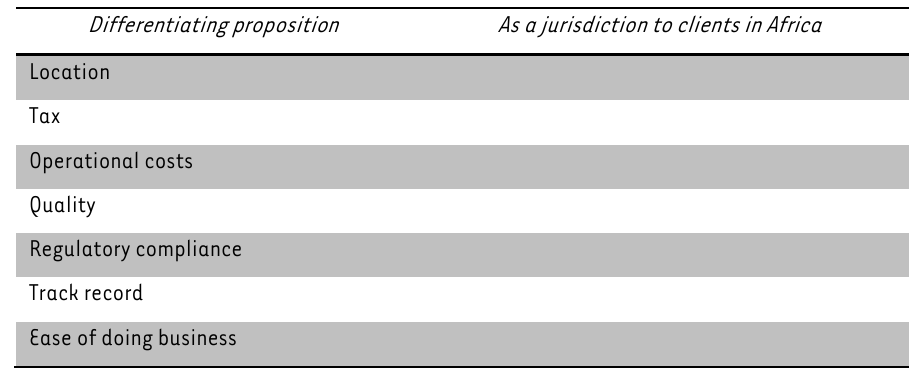
TABLE 2: Template of ‘where’ assessment of reputational